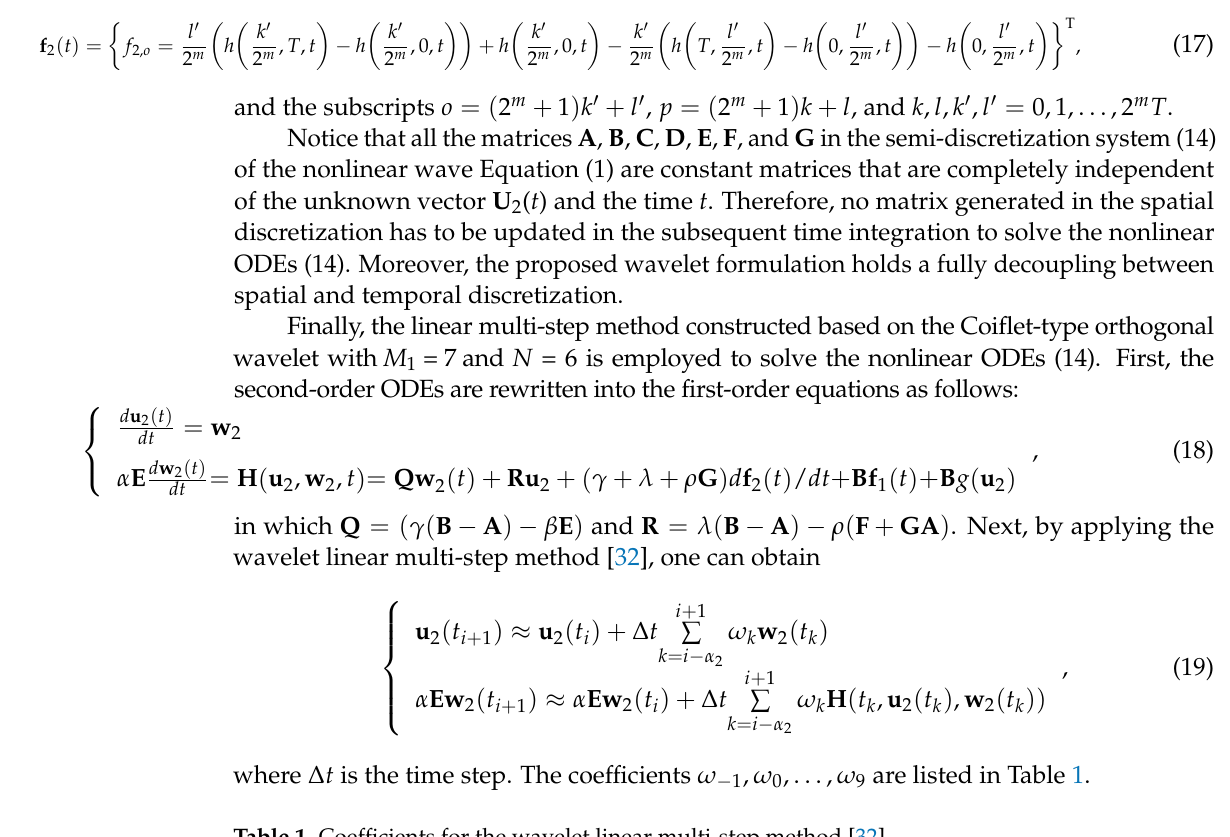
Table 1. Coefficients for the wavelet linear multi-step method